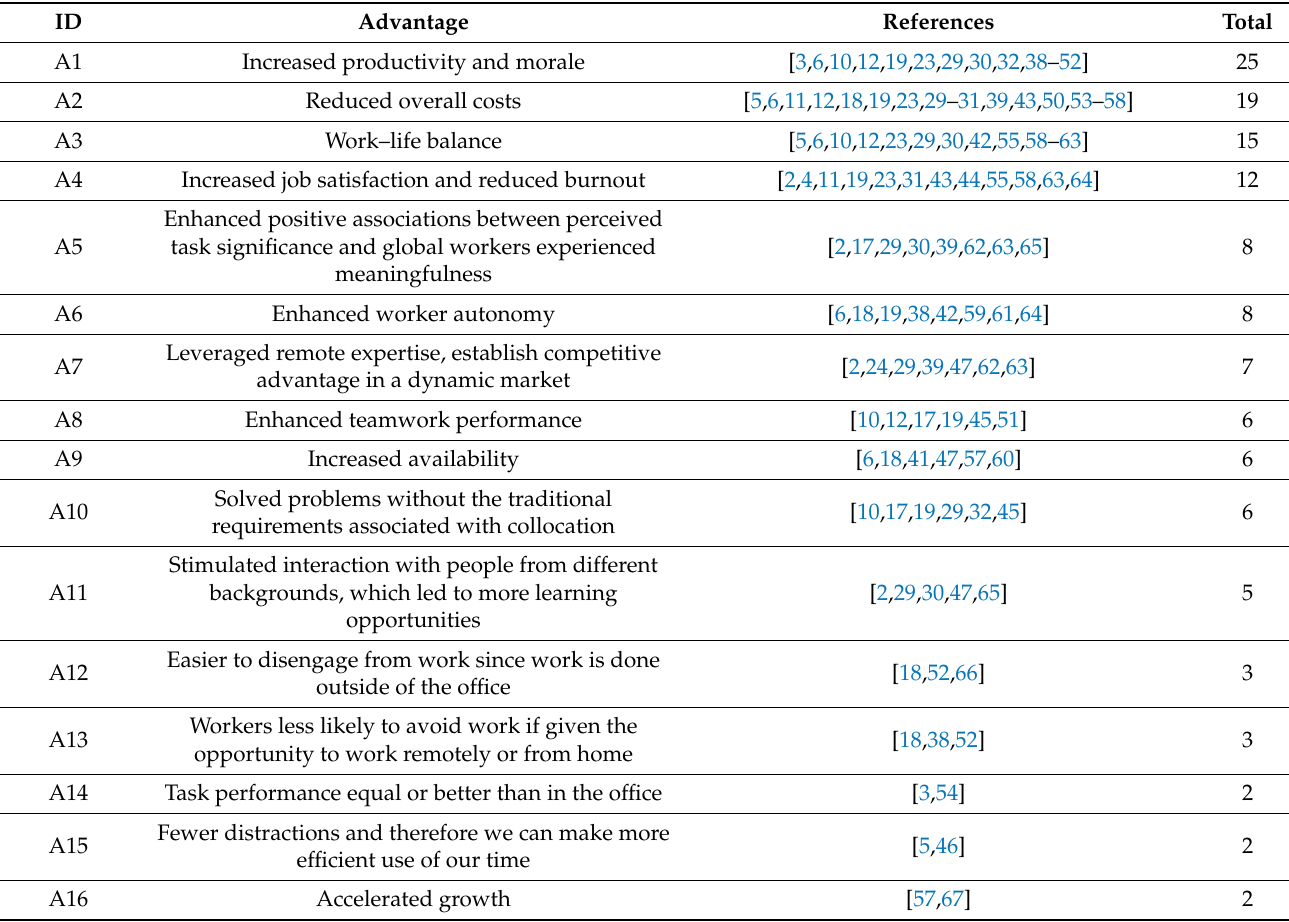
Table 4. RW advantages elicited from the performed SLR.